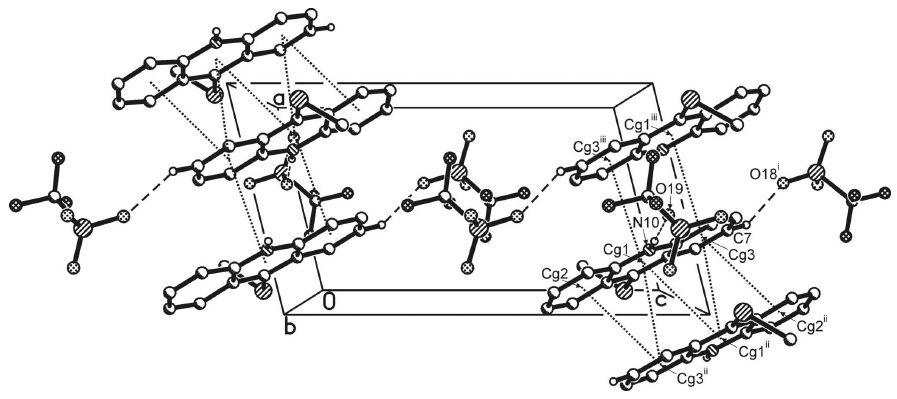
Figure 2 The arrangement of the ions in the crystal structure. The N–H···O and C–H···O hydrogen bonds are represented by dashed lines, the π - π contacts by dotted lines. H atoms not involved in the interactions have been omitted. [Symmetry codes: (i) -